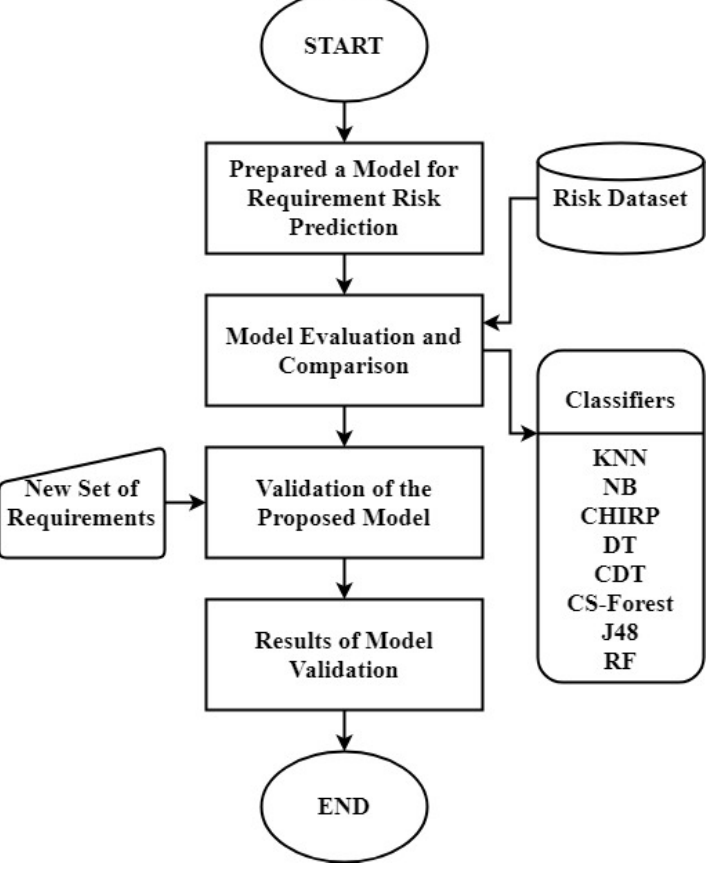
Figure 2. Proposed research